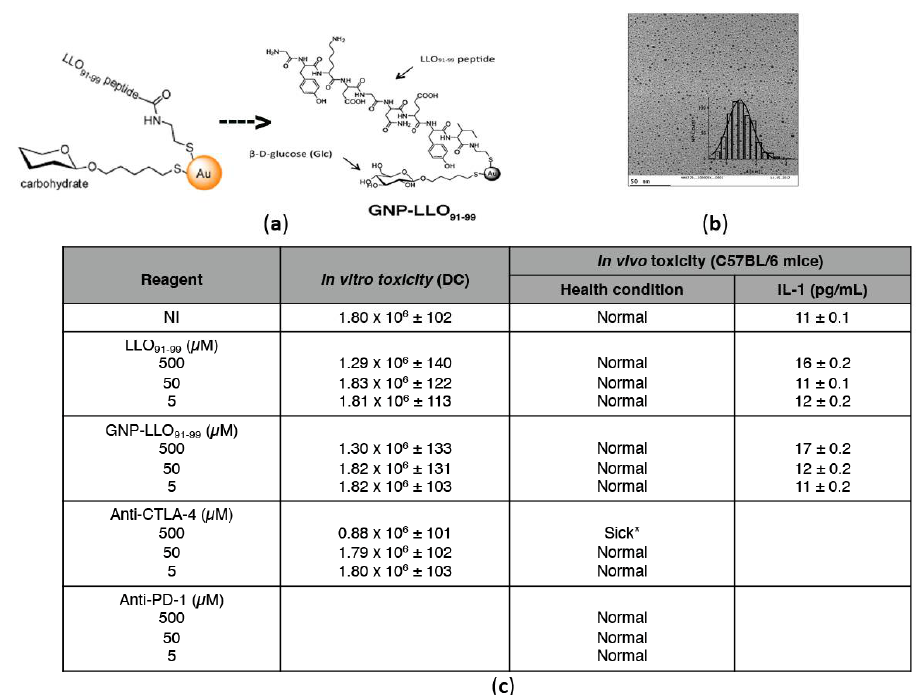
(Figure 1b). Different concentrations of GNP-LLO 91–99 nanovaccines or LLO 91–99 peptide (5–500 µ M) were non-toxic for human MoDCs after incubation for 16 h, as determined by evaluating the cell viability with Trypan blue staining (Figure 1c). We also observed no tox- icity in mice (C52BL/6 male and female, n = 10) when we inoculated intraperitoneally (i.p.) for 16 h with GNP-LLO 91–99 nanovaccines or LLO 91–99 peptide (5–500 µ M) (Figure 1c, center and right columns) and examined mice health conditions and sera IL-1 concentrations.